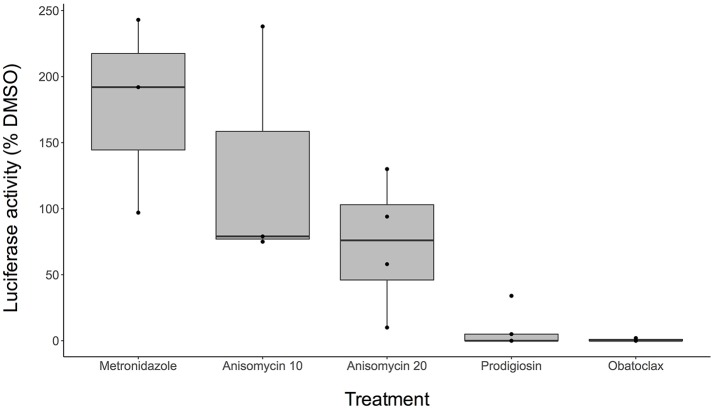
Activity against E. invadens mature cysts. Boxplot indicates range of data (percent luciferase activity compared to DMSO control) for at least 3 biological replicates for each drug concentration. Black dots (•) show each separate trial. MNZ was performed at 20 μM concentration, anisomycin at both 10 and 20 μM (labeled as Anisomycin 10 and Anisomycin 20, respectively), and prodigiosin and obatoclax at 10 μM.